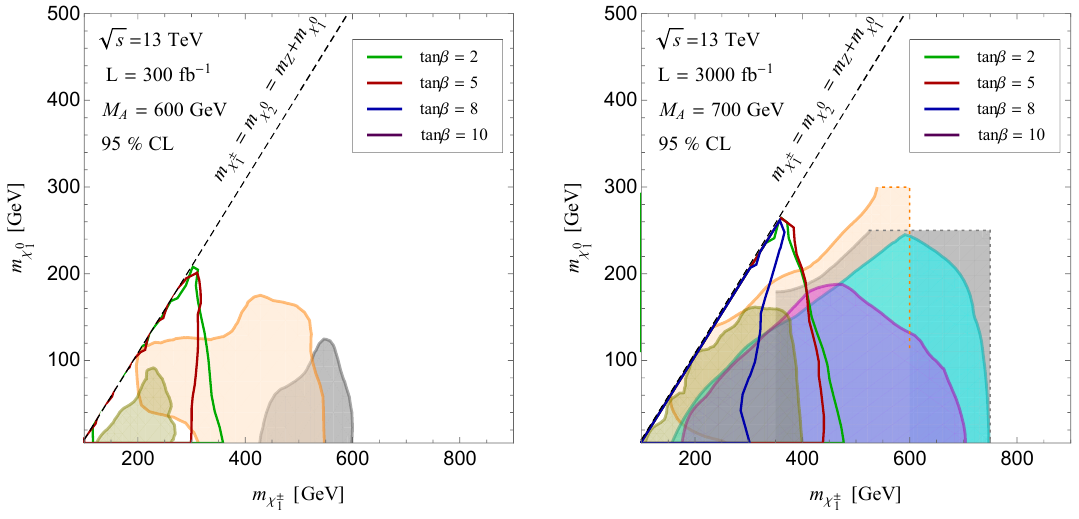
Figure 8 . Comparison between the H=A existing direct production constraints for the higgsino-like electroweakinos at HL-LHC. In the case of the resonant Higgs channel we present the bounds for m A = 600 (700) GeV for luminosity of 300 (3000) fb (cid:0) 1